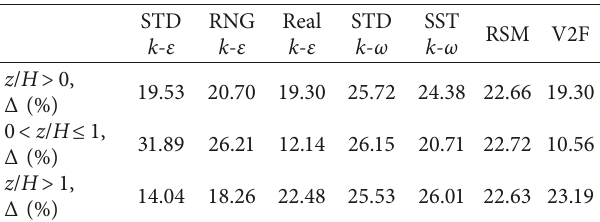
Table 4: Percentage differences between measured and modeled velocities within and above the canyon (AR